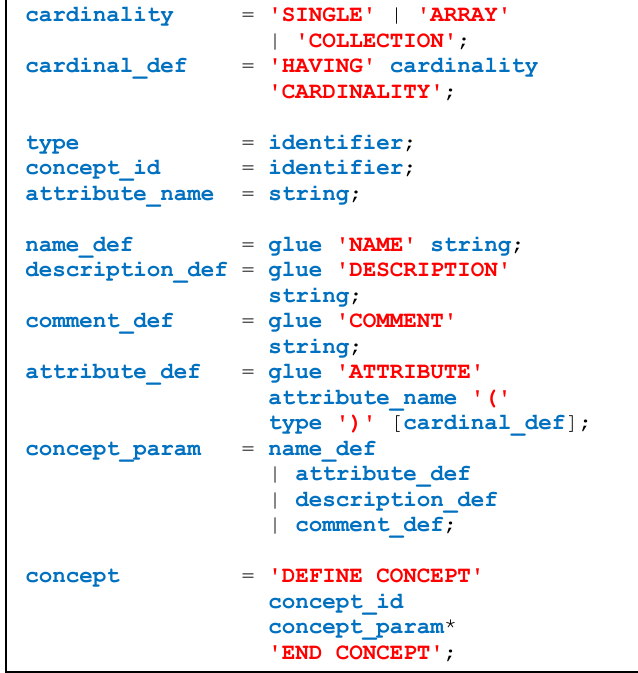
Fig. 3. Concept definition in the proposed DSL